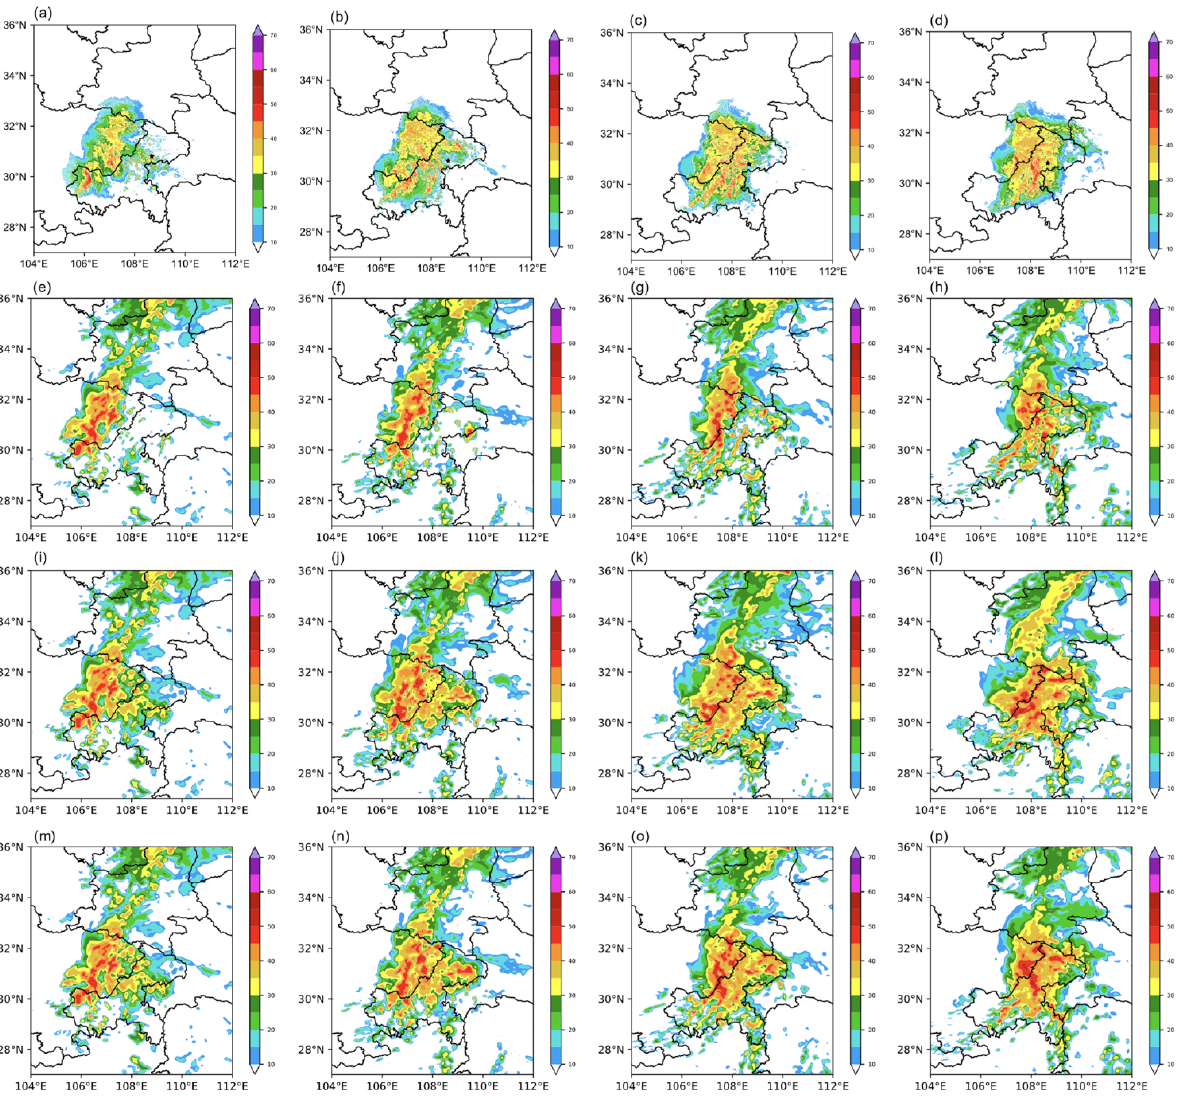
Figure 8. The composite reflectivity (shaded; units: dBZ) from observation ( a – d ), CTRL ( e – h ), ψ − χ ( i – l ), U − V ( m – p ) at 2100 UTC 04 (the first column), 2200 UTC 04 (the second column), 2300 UTC 04 (the third column) and 0000 UTC 05 (the last column).